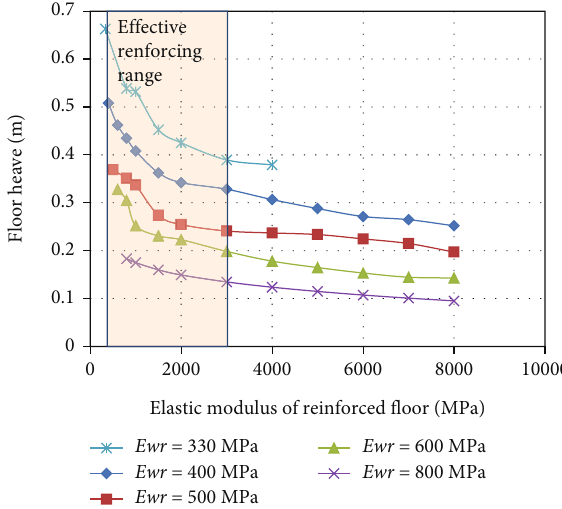
Figure 14: The graph of fl oor heave value ( H fl ) along the roadway axis on the elastic modulus of the reinforced zone ( E r ) for di ff erent variants of elastic modulus of the wet surrounding rock mass ( E wr